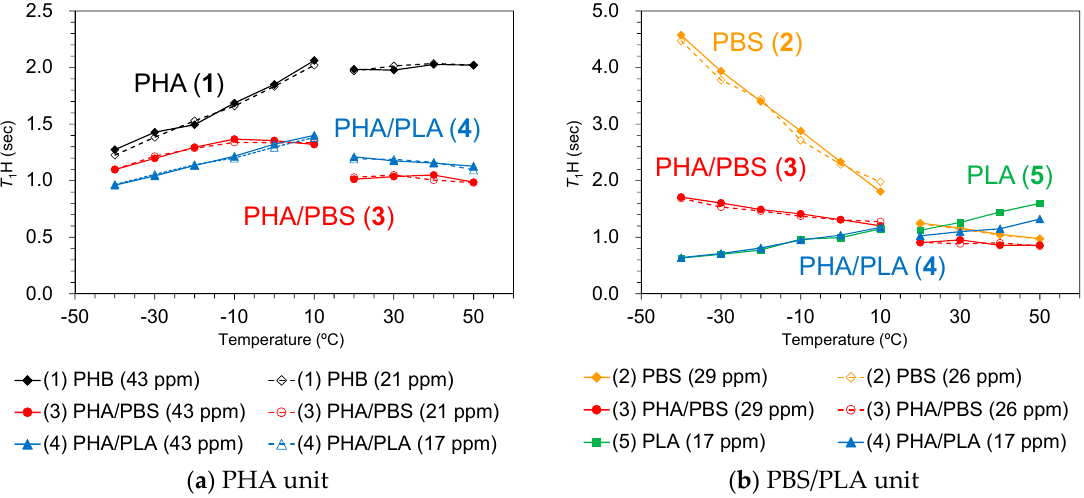
Figure 8. T 1 H changes of PHA ( a ) and poly(butylene succinate)/poly(lactic acid) (PBS/PLA) units ( b ) in plasticized PHA copolymers with rising temperature. The temperature was increased from 40 °C to − 10 °C (low temperature side) and from 20 °C to 50 °C (high temperature side).